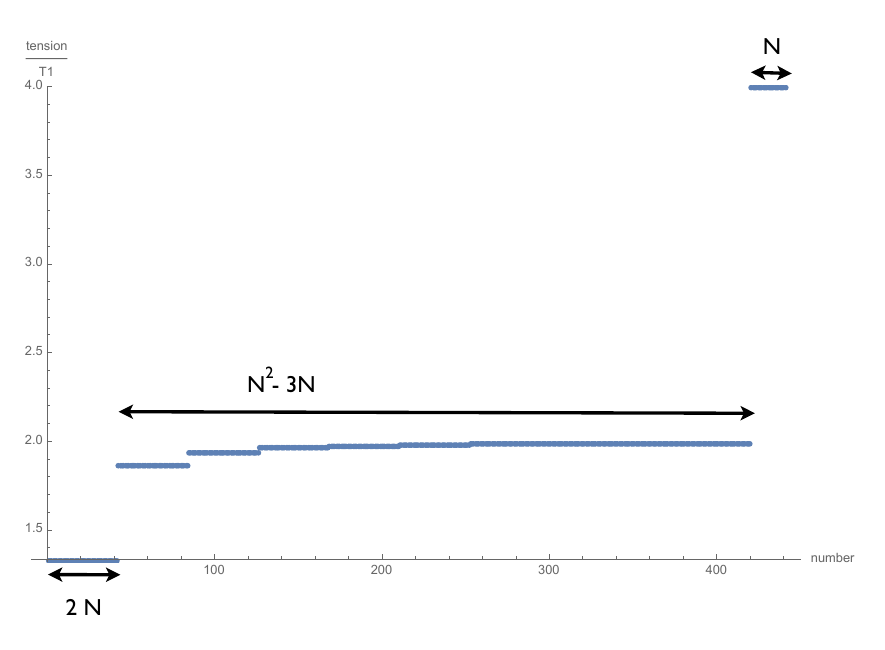
(cid:3) -representation string tensions ^ T ab Figure 7 . The product (cid:3) (cid:3) (cid:10) (cid:3) , evaluated for N = 21. They (cid:10) take values between 1 : 32 and 3 : 99 times the fundamental string tension. As the plot shows, 42 = O ( N ) string tensions take the minimal value (these correspond to a = b 1(mod N )), (cid:6) 21 = O ( N ) tensions approximately equal four times the fundamental string tension (corresponding to a = b ) and the rest of the string tensions (378 = O ( N 2 )) are slightly less than twice the fundamental string